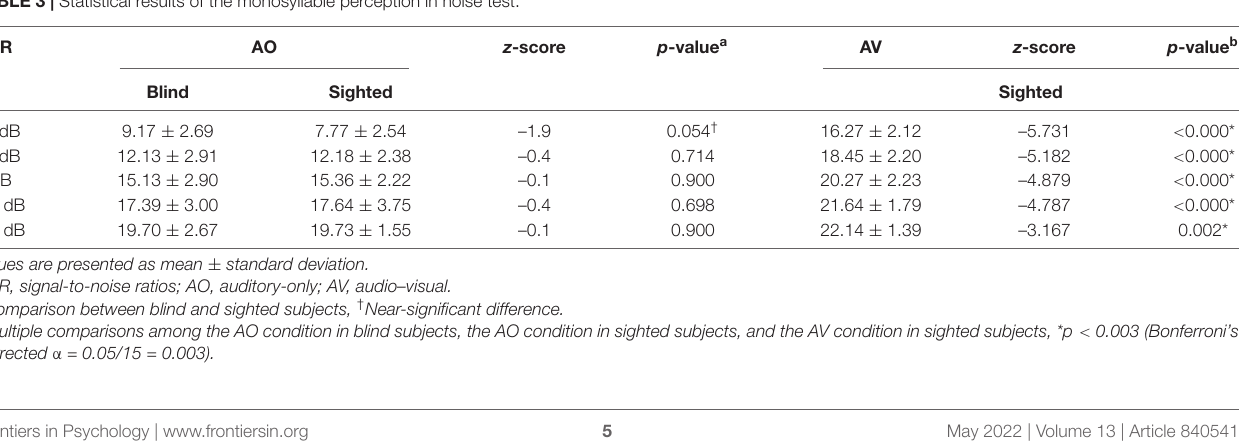
TABLE 3 | Statistical results of the monosyllable perception in noise test.